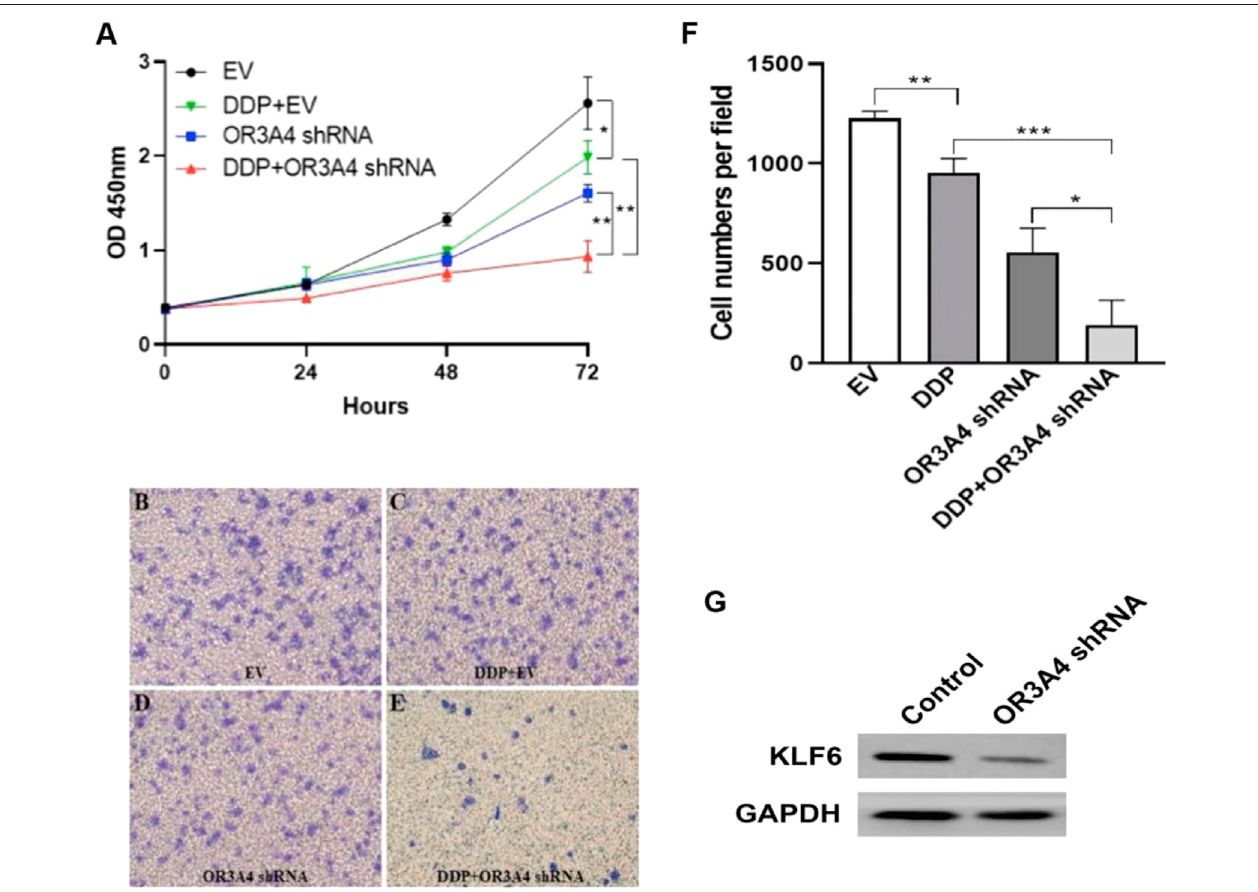
FIGURE 4 | Knockdown of OR3A4 in SKOV3 cells enhanced the antitumor effect of cisplatin (A) The proliferation level of cells processed by DDP and simultaneously knocked down OR3A4 was signi fi cantly lower than those treated individually (B – F) The migration level of cells treated with DDP while knocking down OR3A4 was considerably lower than those treated individually (B – E) The representative images of transwell experiments (F) The statistical analysis of cell migration (G) KLF6 expression in SKOV3 cells while knocking down OR3A4. *p < 0.05, **p < 0.01, ***p < 0.001.